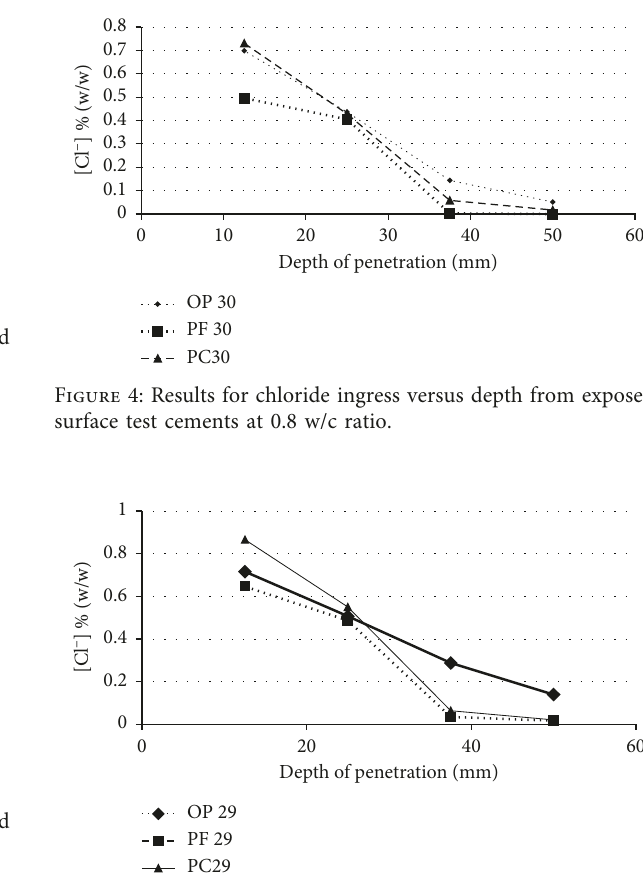
Figure 5: Results for chloride ingress versus depth from exposed surface for the test cements at 0.85 w/c ratio.